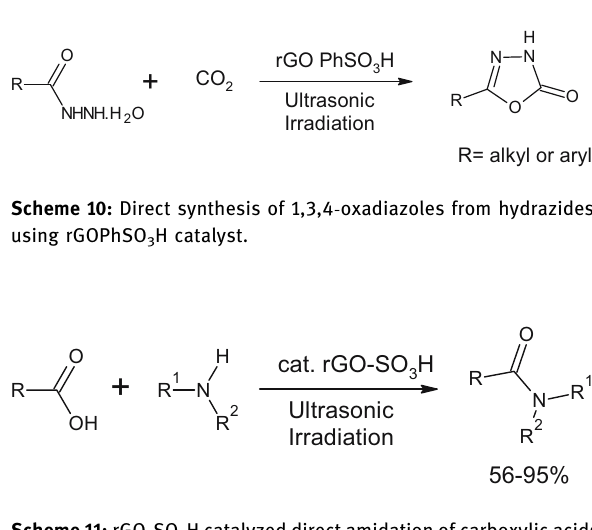
Scheme 11: rGO - SO 3 H catalyzed direct amidation of carboxylic acids with